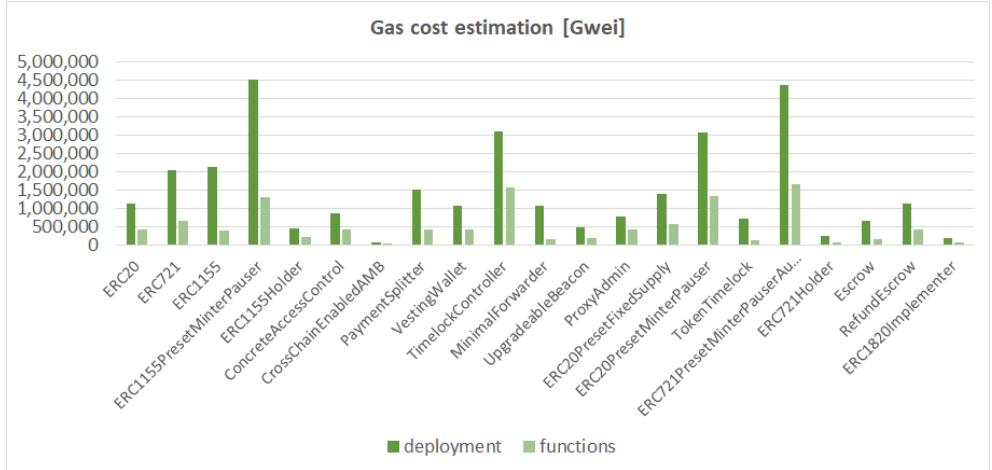
Figure 7. Cost estimation of the deployment process and available functions in deployable smart